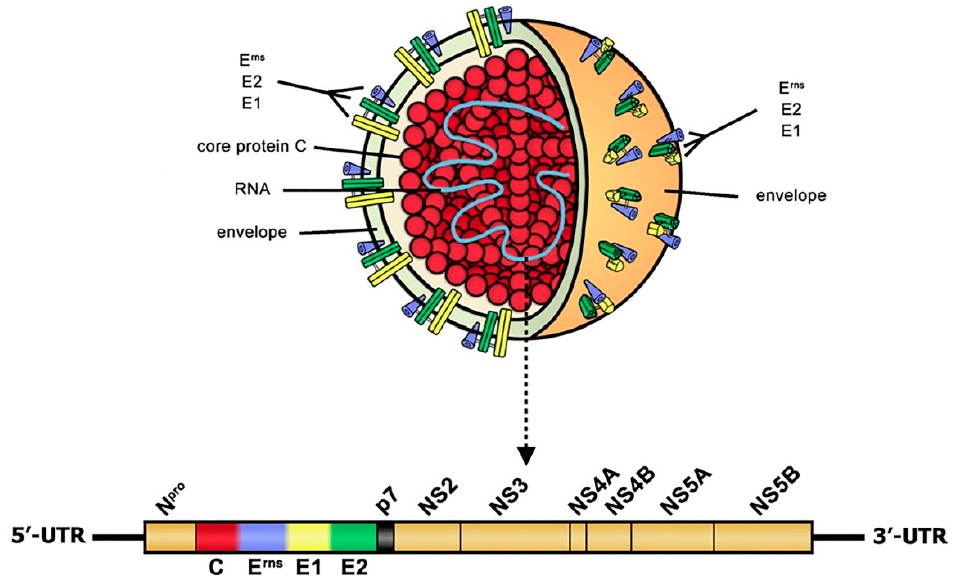
Figure 1. Schematic description of virion structure and genome organization of classical swine fever virus (CSFV) [4]. This figure comes from the literature reported by Beer et al. [4] with some modifications. CSFV is an enveloped, single-stranded, positive-sense RNA virus. Glycoproteins (E rns , E1, and E2) are located on the external part of viral particles and are important for viral infection. CSFV RNA genome consists of a single large open reading frame (ORF) flanked by a 5 ′ -untranslated region (5 ′ -UTR) and a 3 ′ -UTR. A polypeptide precursor could be encoded by ORF of CSFV and then cleaved into four structural proteins (C, E rns , E1, and E2) and eight non-structural proteins (N pro , p7, NS2, NS3, NS4A, NS4B, NS5A, and NS5B).